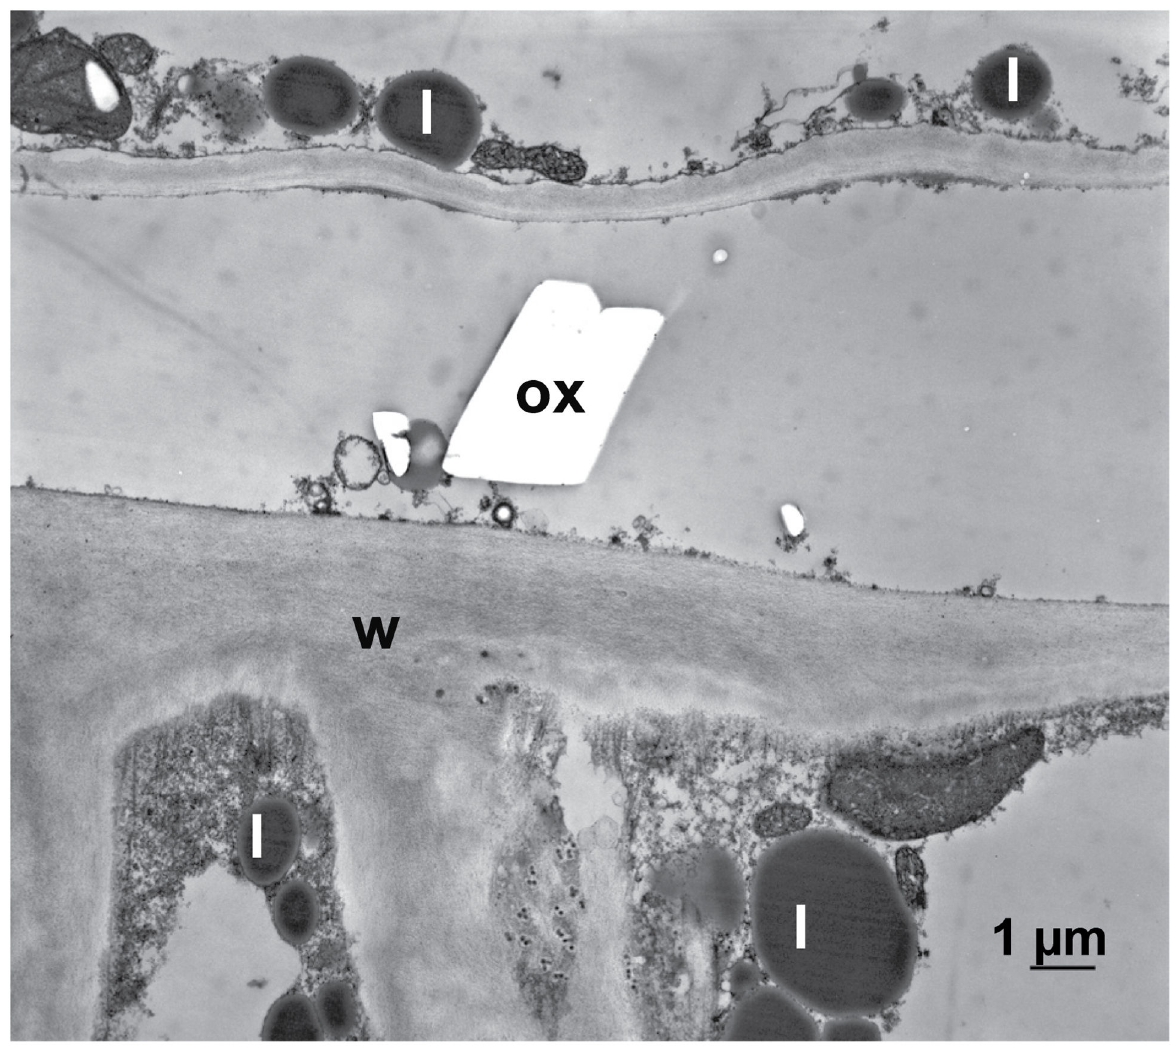
Figure 11. The Effect of oxalic acid on non-infected, inactivated host tissue. Transmission electron micrograph of a cross section of sunflower hypocotyl. After inactivating the tissue by glutaraldehyde fixation it was treated with oxalic acid and additionally with calcium chloride to precipitated calcium oxalate: In the inactivated tissue calcium oxalate crystals (ox) appeared. The accumulation of lipid bodies (l) is indicating the beginning of decomposition of the membranous system of the cell; cell wall (w).